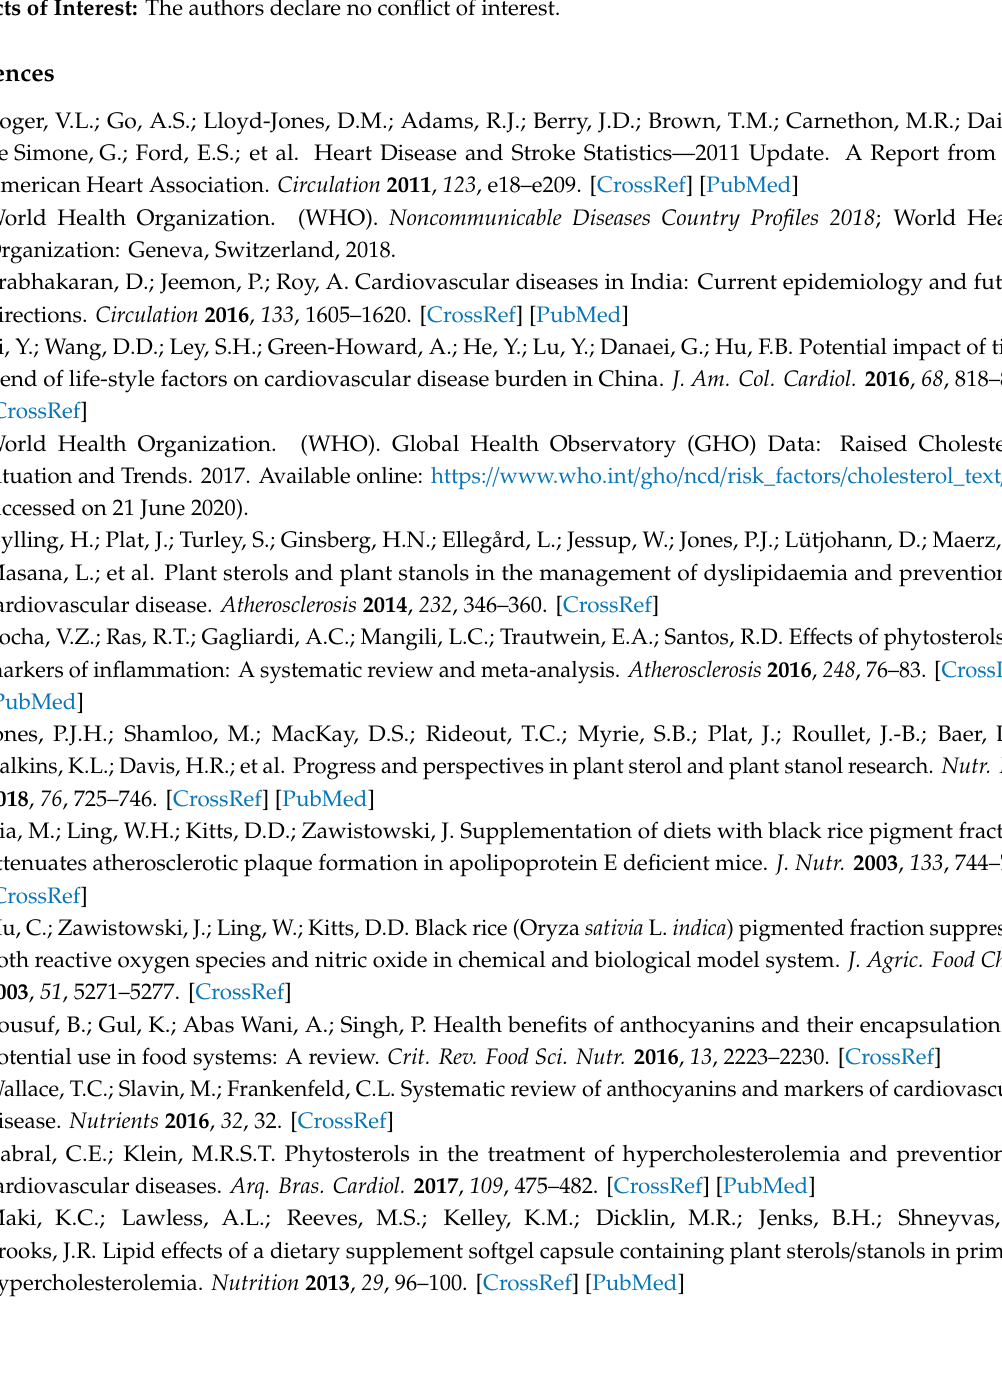
Supplementary Materials: The following are available online. Table S1: Body gain, heart, liver, weight, hematocrit, and hemoglobin in